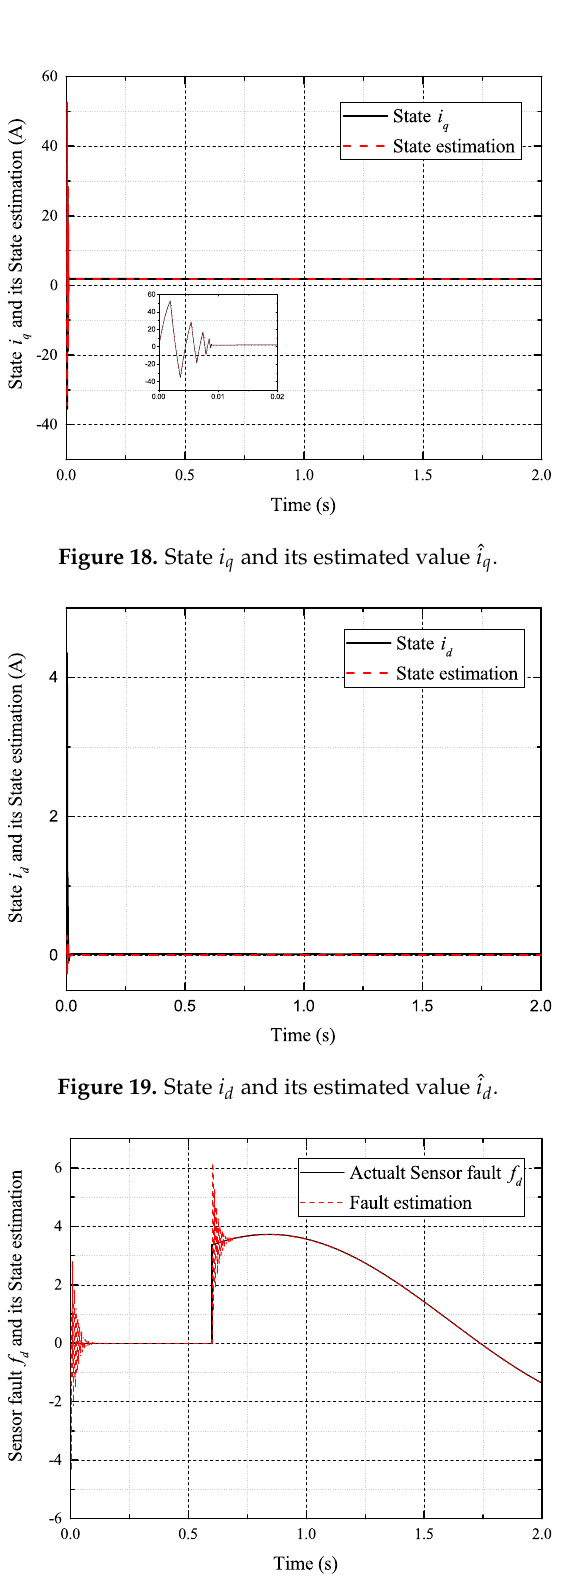
Figure 20. Sensor fault f d and its estimated value ˆ f d